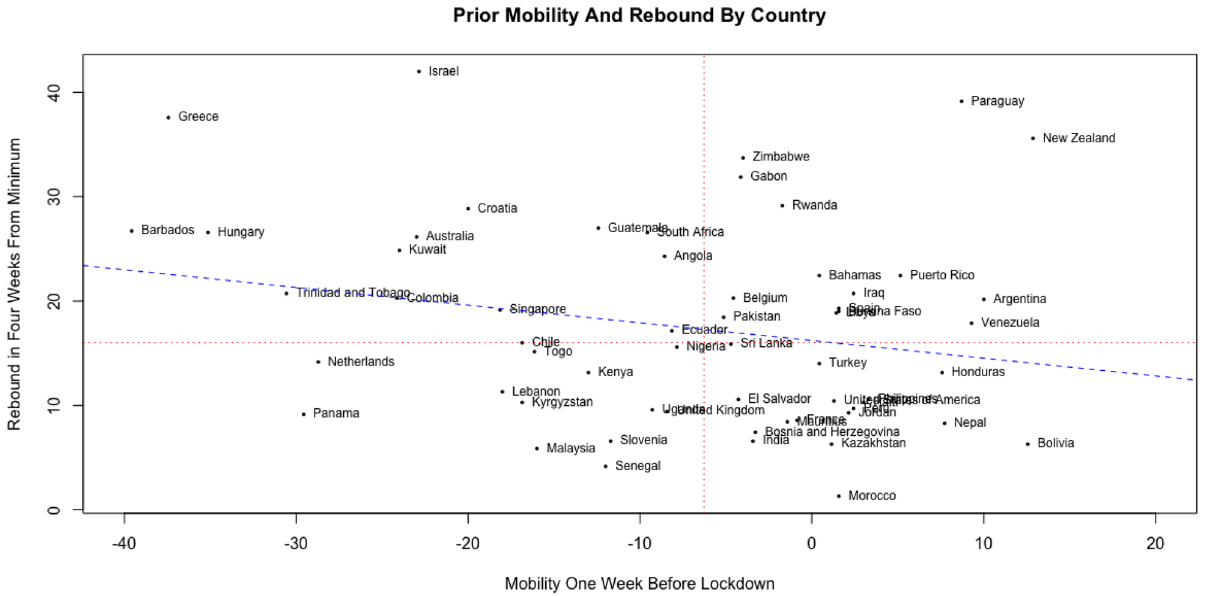
Figure 4. Prior mobility and rebound across n = 59 countries. The horizontal axis represents the average mobility level 1 week before the start of the lockdown. The vertical axis represents the rebound in mobility in 4 weeks starting from the day when minimum mobility levels were achieved during the